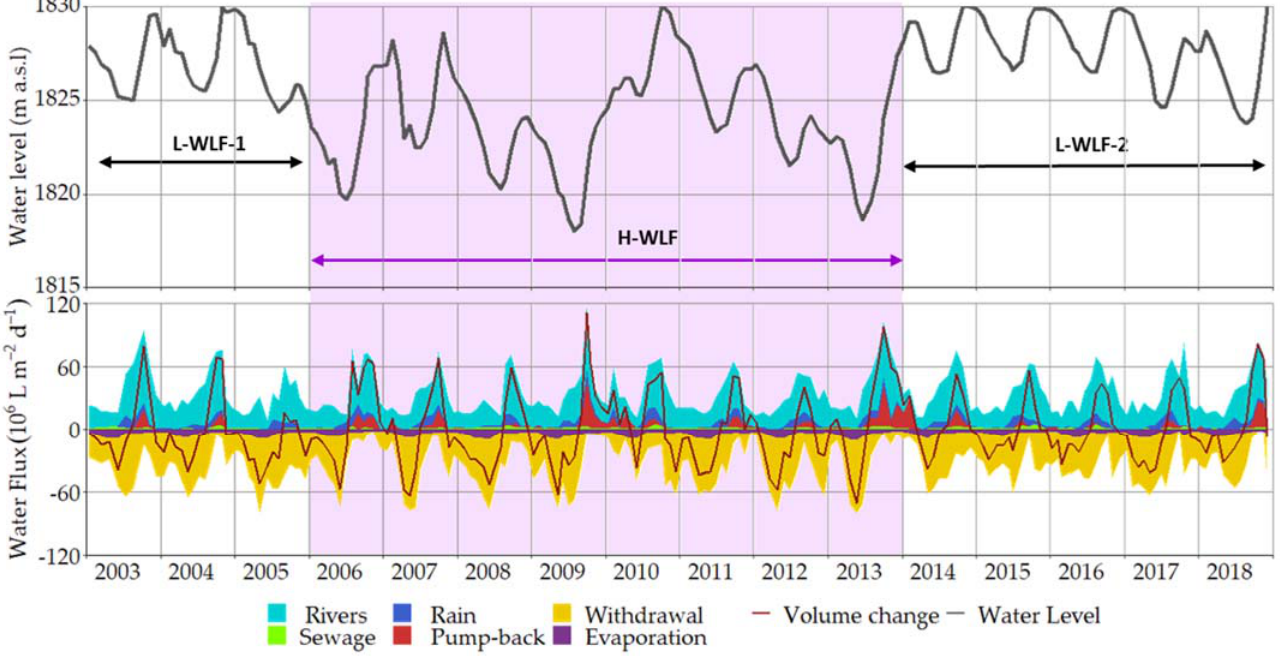
Figure 3. Water budget fluxes (m 3 m − 2 d − 1 ) of Valle de Bravo and its water level variations from 2003–2018. Purple shading outlines the higher water level fluctuation (H-WLF) period.